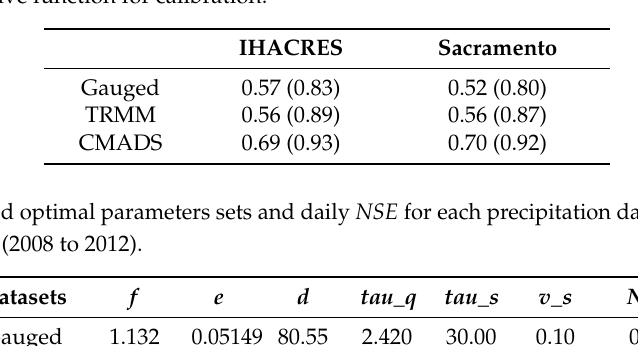
Table 4. Overall performance (daily NSE (monthly NSE )) of precipitation datasets for models using NSE as the objective function for calibration.